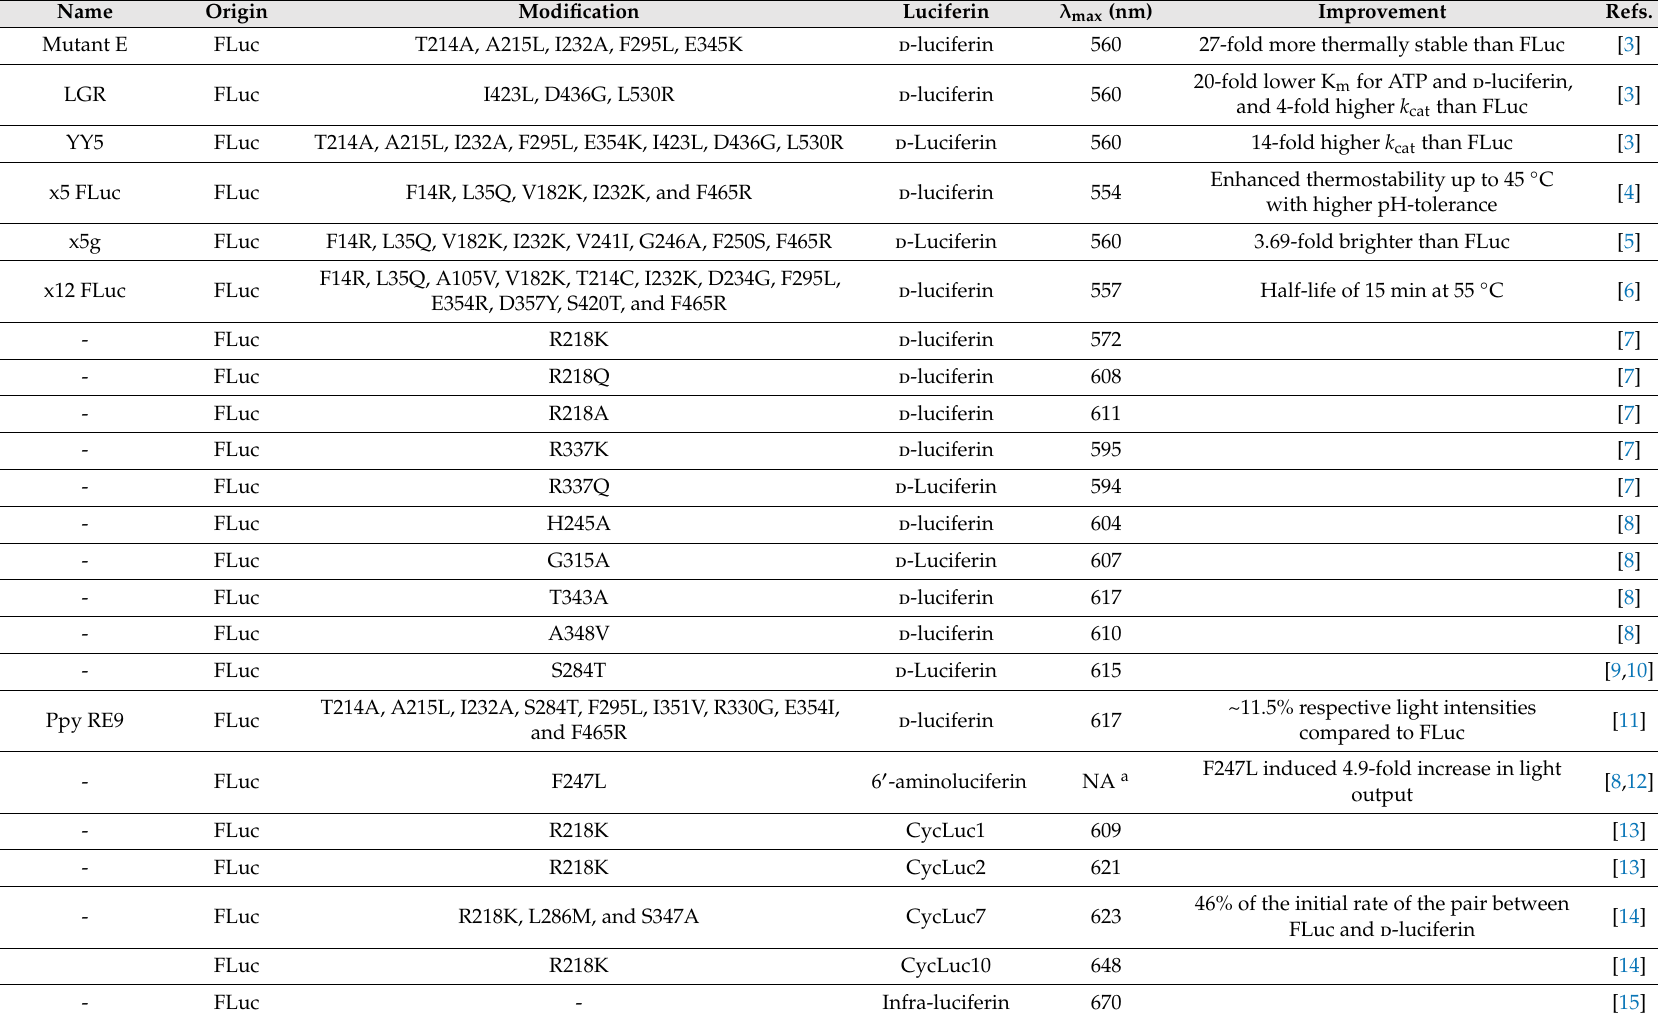
Table 1. The genetically or chemically engineered bioluminescence